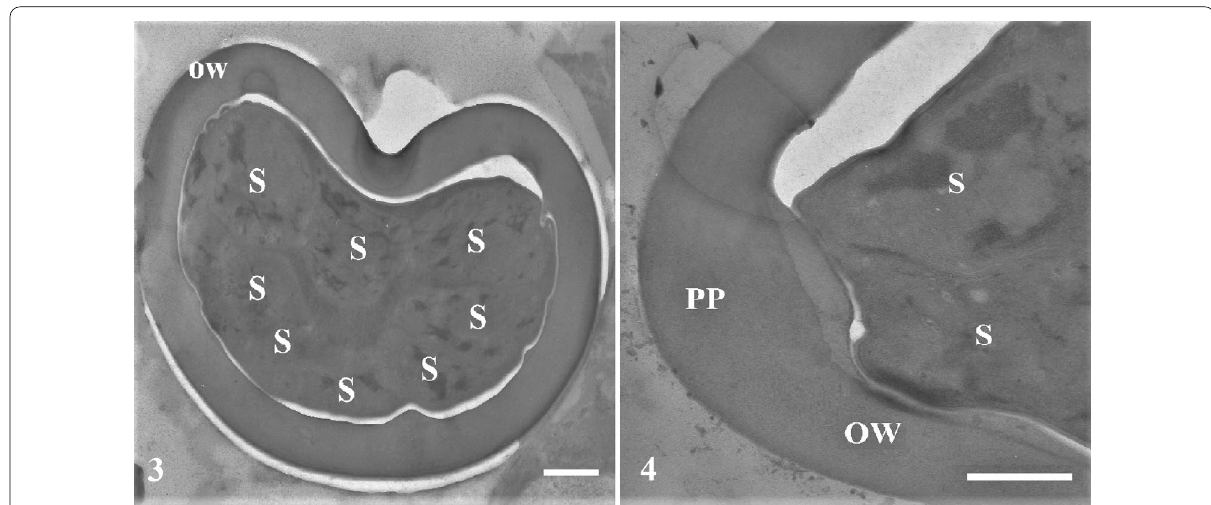
Figs. 3–4 Ultrastructure of mature oocysts of Mattesia dispora , TEM. Longitudinal 3 and cross 4 sections of oocyst including eight sporozoites. S sporozoites, OW oocyst wall, PP polar plug. Bars, 1 μm